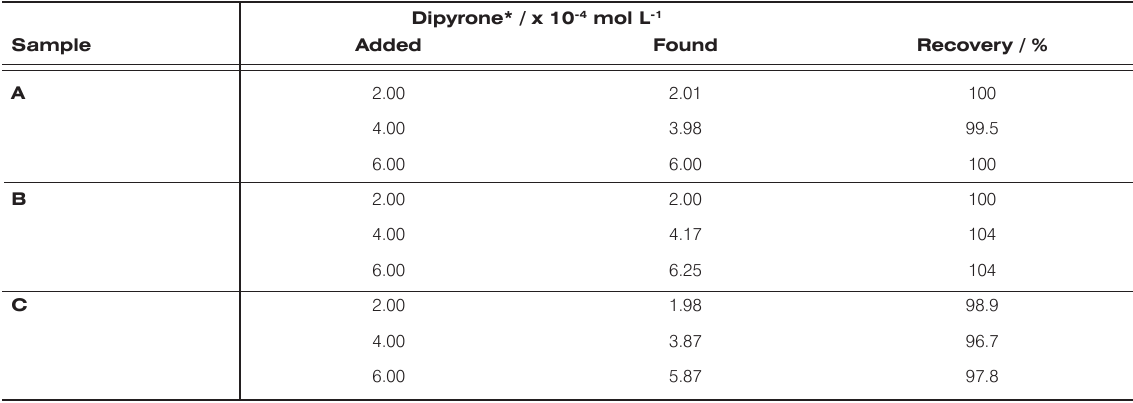
Table 2. Results of addition-recovery experiments using FIA spectrophotometric procedure for three different standard concentrations of